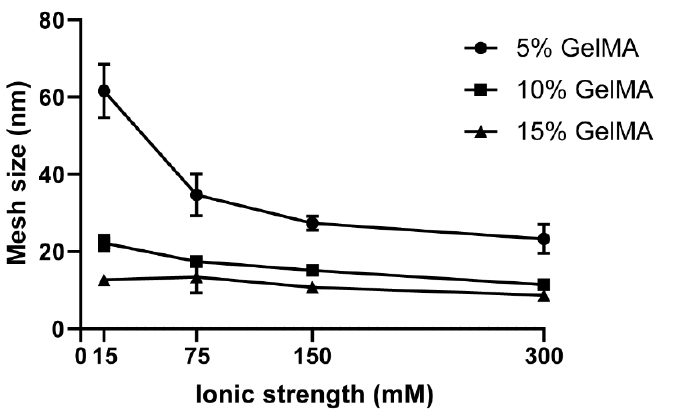
Figure 5. Mesh size for GelMA hydrogels (5% to 15%) crosslinked in water and swelled at different ionic strengths.